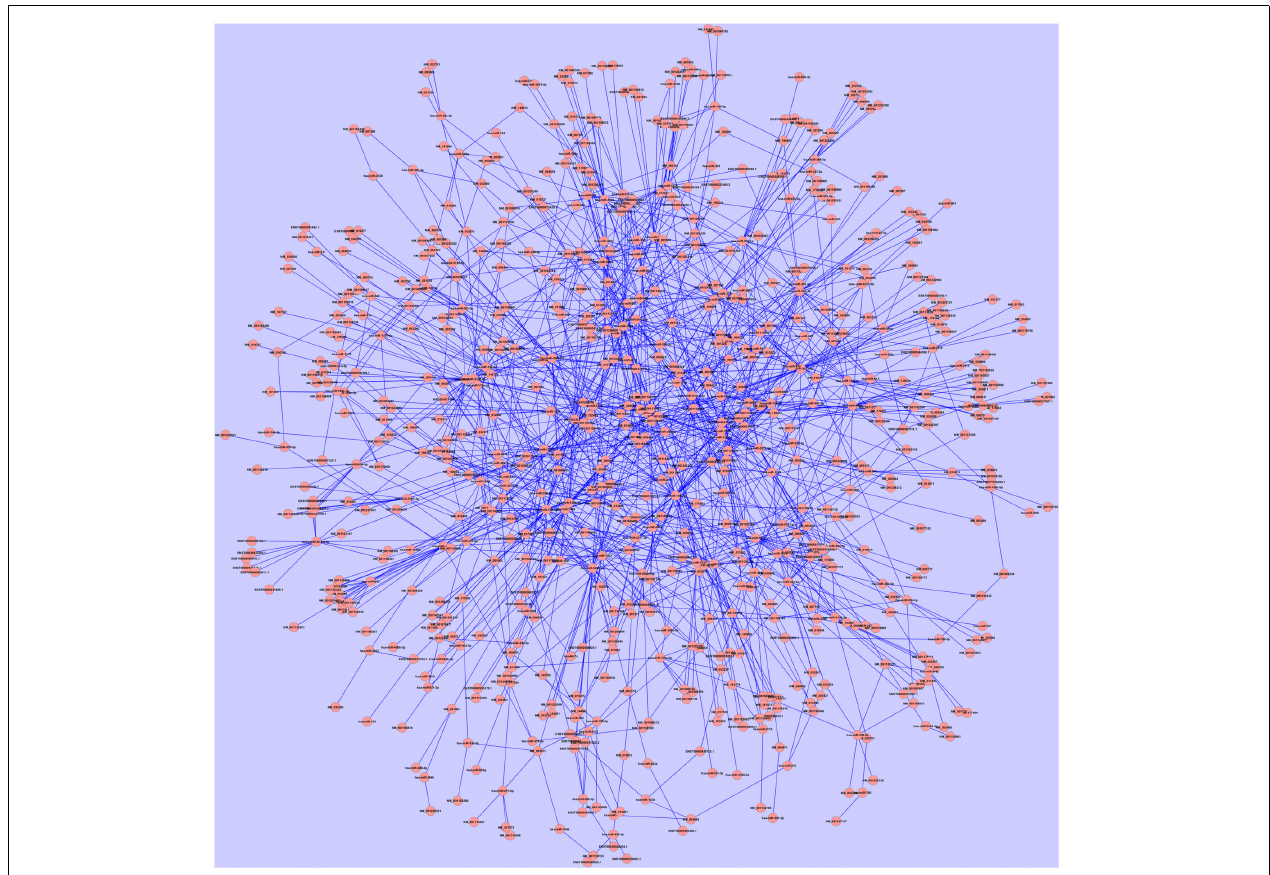
FIGURE 3 | The ceRNA network in KSHV infected PEL cells incorporating predictedcellularprotein-coding,lncRNAandcircRNAtargetsofbothhost cellularandviralmiRNAsidentifiedfromAGOPAR-CLIPdata. Thenetwork